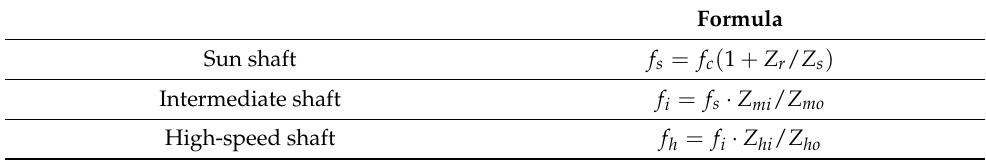
Table 2. Rotational frequencies of different shafts in the gearbox with one planetary stage and two parallel stages.